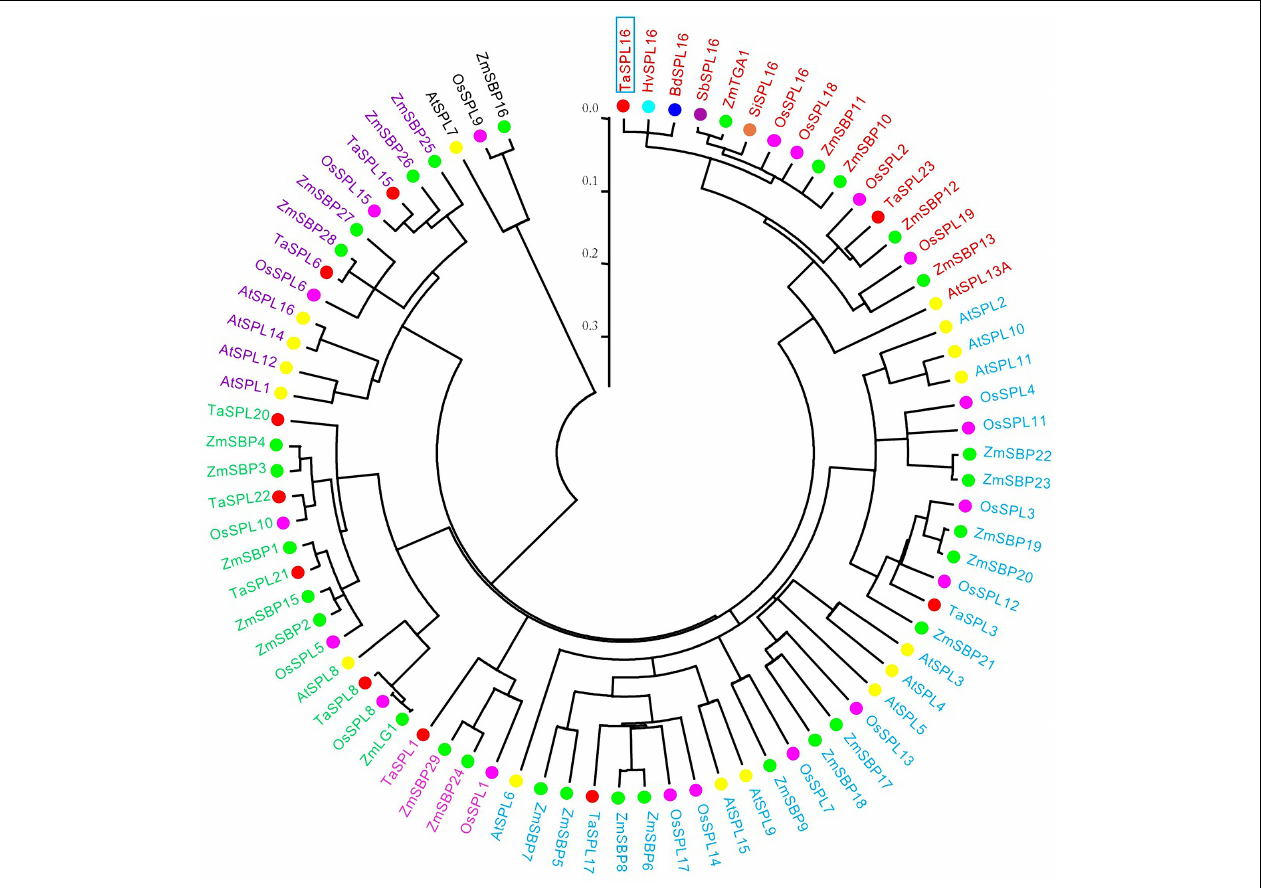
FIGURE 1 | Phylogenetic analysis of TaSPL16 and other SPL genes based on the conserved SBP domain. The tree was constructed by alignment of a total of 79 SPLs , including 16 from Arabidopsis , 19 from rice, 30 from maize, 11 from wheat, and the orthorolog of SbSPL16 from sorghum, barley, millet, Brachpodium distachyon, using ClustalW, and MEGA5.05 was used to generate a neighbor-joining tree with 1000 bootstrap replicates. The scale bar indicates the average number of amino acid substitutions per site. TaSPL16 is marked with blue box. Filled circles in different colors represent different species; genes in the same clades are with the same color. At, Arabidopsis ; Bd, Brachypodium distachyon ; Hv, Hordeum vulgar ; Sb, Sorghum bicolor ; Si, Setaria italica ; Os, Oryza sativa ; Ta, Triticum aestivum ; Zm, Zea mays